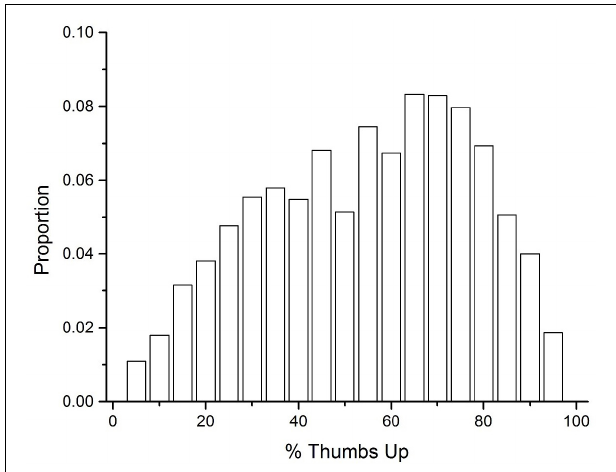
FIGURE 4 | A histogram of the percent thumbs up for all UD definitions.